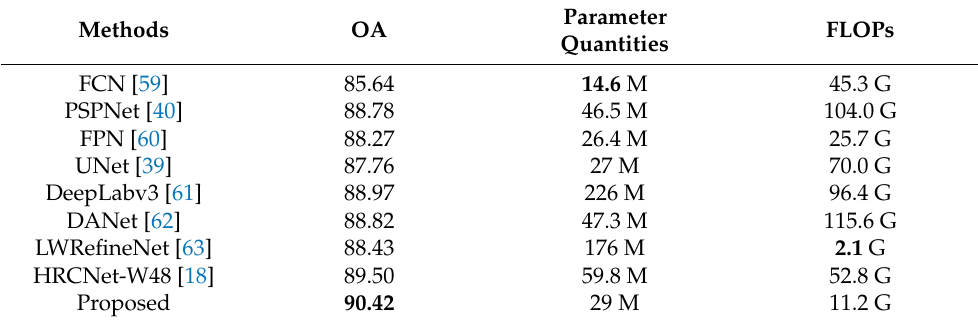
Table 9. Complexity comparison on the Potsdam